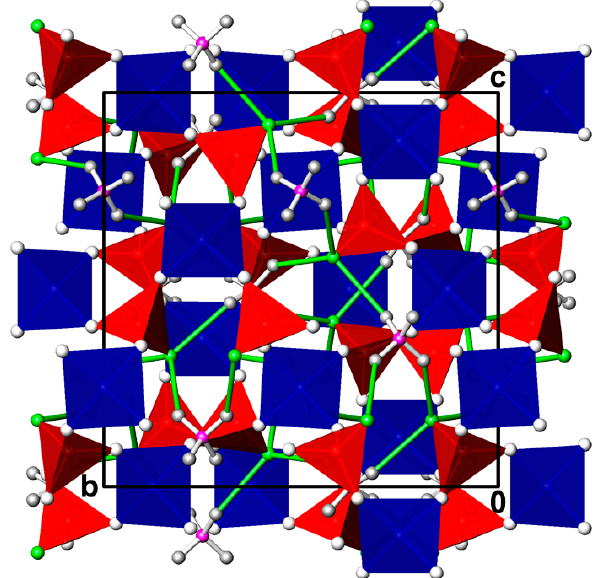
Figure 13. The crystal structure of (NH 4 ) 2 Zn 3 (PO 3 F) 4 (H 2 O) in a projection along [- 100] giving only the major part of the disordered Zn site. Colour code of PO 3 F tetrahedra as in Figure 1; [ZnO 4 ] tetrahedra are given in blue and (N,O)–H···F hydrogen bonding is indicated by green lines. For clarity, (N,O)–H···O hydrogen bonding is not shown.